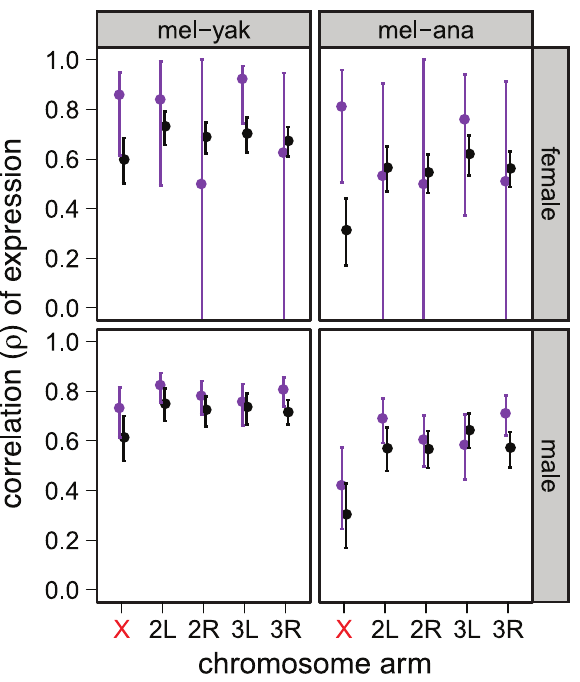
Figure 3. Faster-X expression evolution for genes expressed in male, but not female, reproductive tissues. Correlations of expression between D. melanogaster (mel) and either D. yakuba (yak) or D. ananassae (ana) are plotted for each chromosome arm using expression measurements from whole females (top) or males (bottom). Genes were included if they are narrowly expressed in non-reproductive tissues (black), female reproductive tissues (purple, top), or male reproductive tissues (purple, bottom). Graphs are the same as in Figure 1.